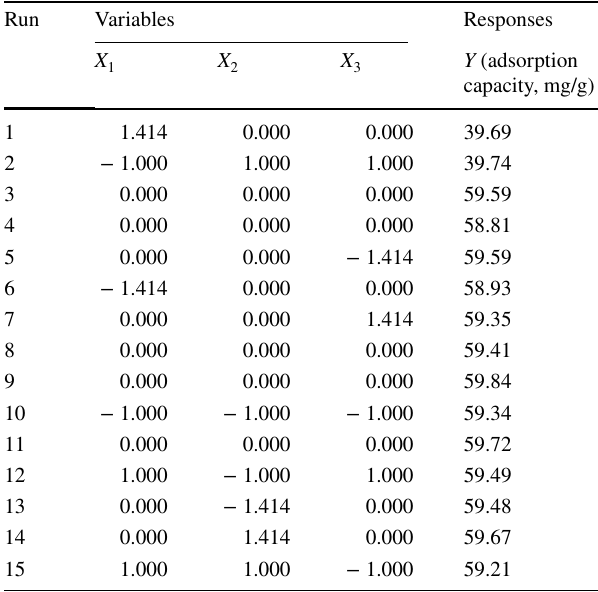
Table 2 Experimental design matrix for preparation of activated car- bon Run Variables